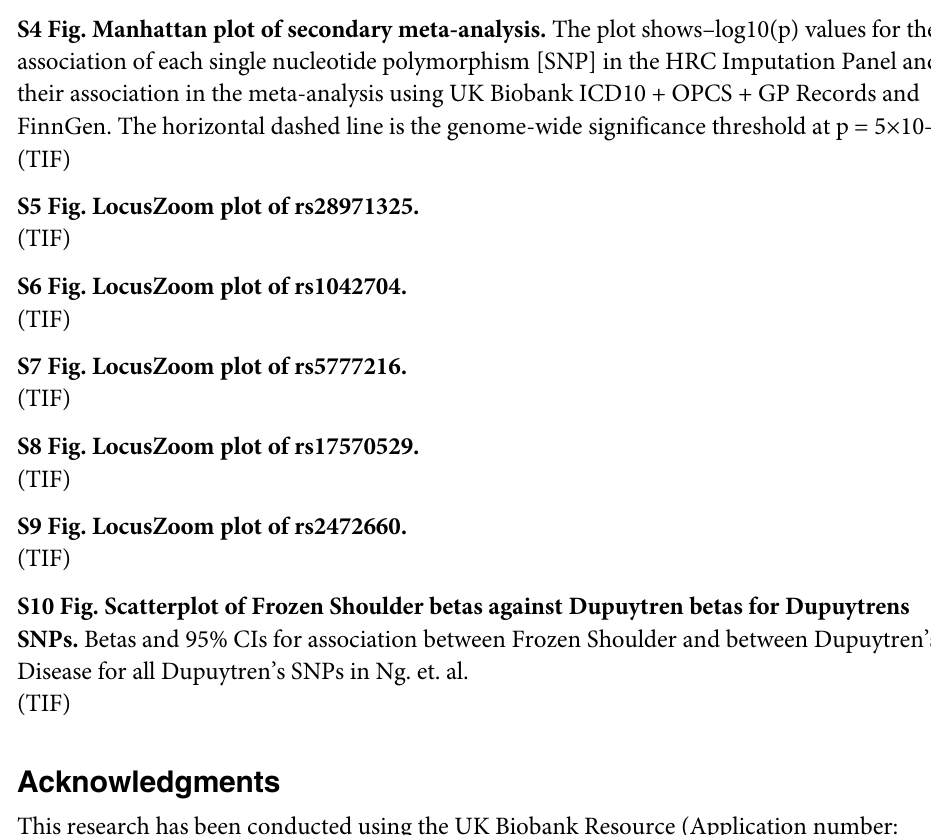
S2 Fig. Manhattan plot of sensitivity analysis GWAS for frozen shoulder in UK Biobank. The plot shows–log10(p) values for the association of each single nucleotide polymorphism [SNP] in the HRC Imputation Panel and their association with UK Biobank frozen shoulder cases defined by ICD10 and OPCS codes. The horizontal dashed line is the genome-wide sig- nificance threshold at p = 5 × 10–8. S3 Fig. Manhattan plot of primary meta-analysis. The plot shows–log10(p) values for the association of each single nucleotide polymorphism [SNP] in the HRC Imputation Panel and their association in the meta-analysis using UK Biobank ICD10 + OPCS and FinnGen. The horizontal dashed line is the genome-wide significance threshold at p = 5 × 10–8. S4 Fig. Manhattan plot of secondary meta-analysis. The plot shows–log10(p) values for the association of each single nucleotide polymorphism [SNP] in the HRC Imputation Panel and their association in the meta-analysis using UK Biobank ICD10 + OPCS + GP Records and FinnGen. The horizontal dashed line is the genome-wide significance threshold at p = 5 × 10–8. (TIF) S5 Fig. LocusZoom plot of rs28971325. S6 Fig. LocusZoom plot of rs1042704. S7 Fig. LocusZoom plot of rs5777216. S8 Fig. LocusZoom plot of rs17570529. S9 Fig. LocusZoom plot of rs2472660. S10 Fig. Scatterplot of Frozen Shoulder betas against Dupuytren betas for Dupuytrens SNPs. Betas and 95% CIs for association between Frozen Shoulder and between Dupuytren’s Disease for all Dupuytren’s SNPs in Ng. et. al.